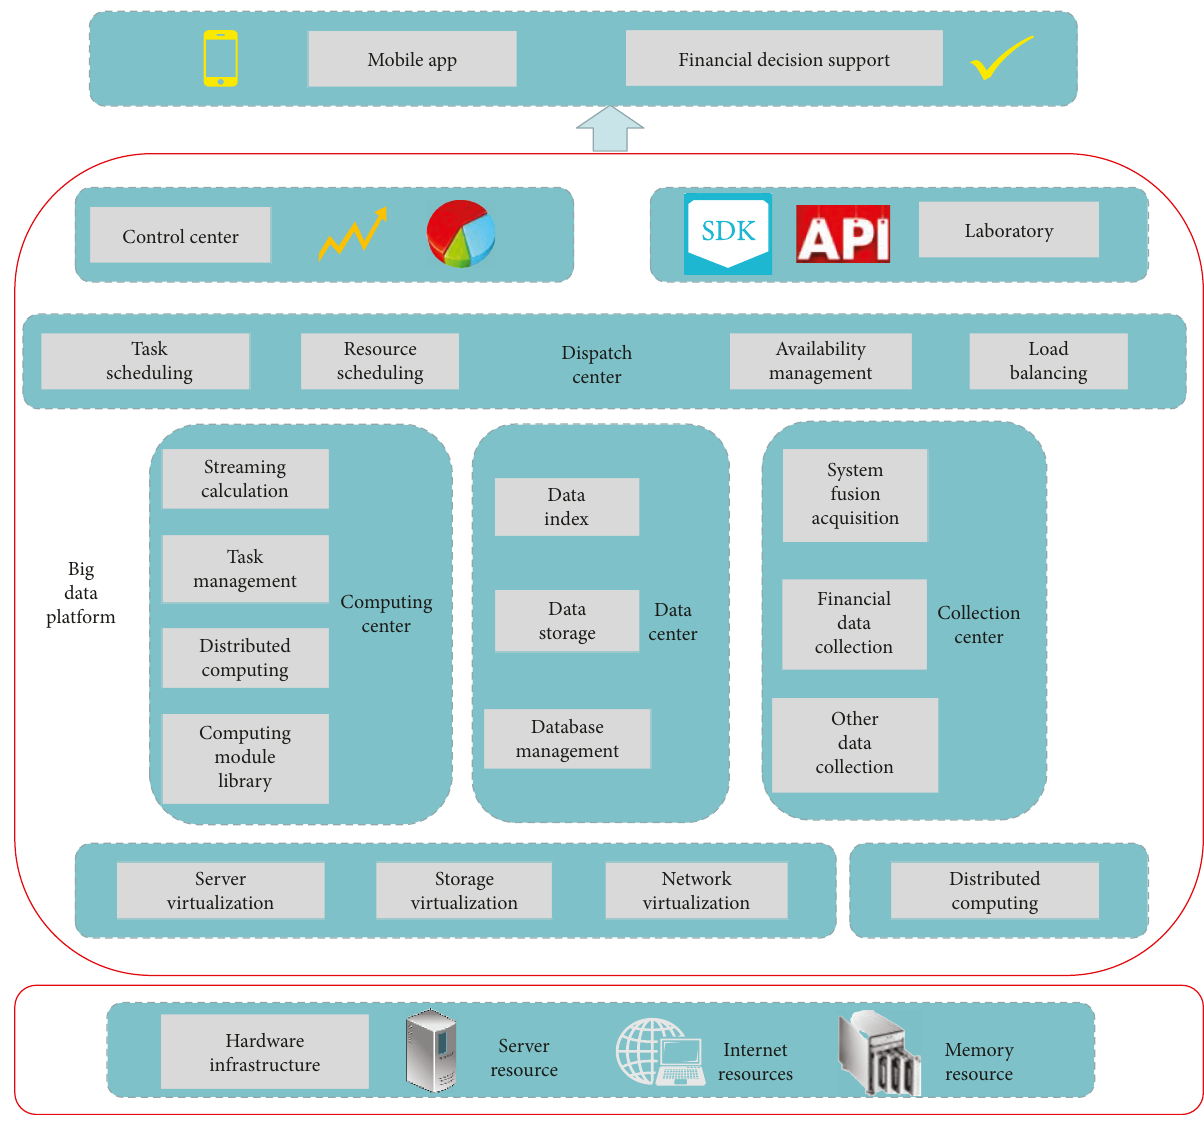
Figure 2: Overall structure view of the big data